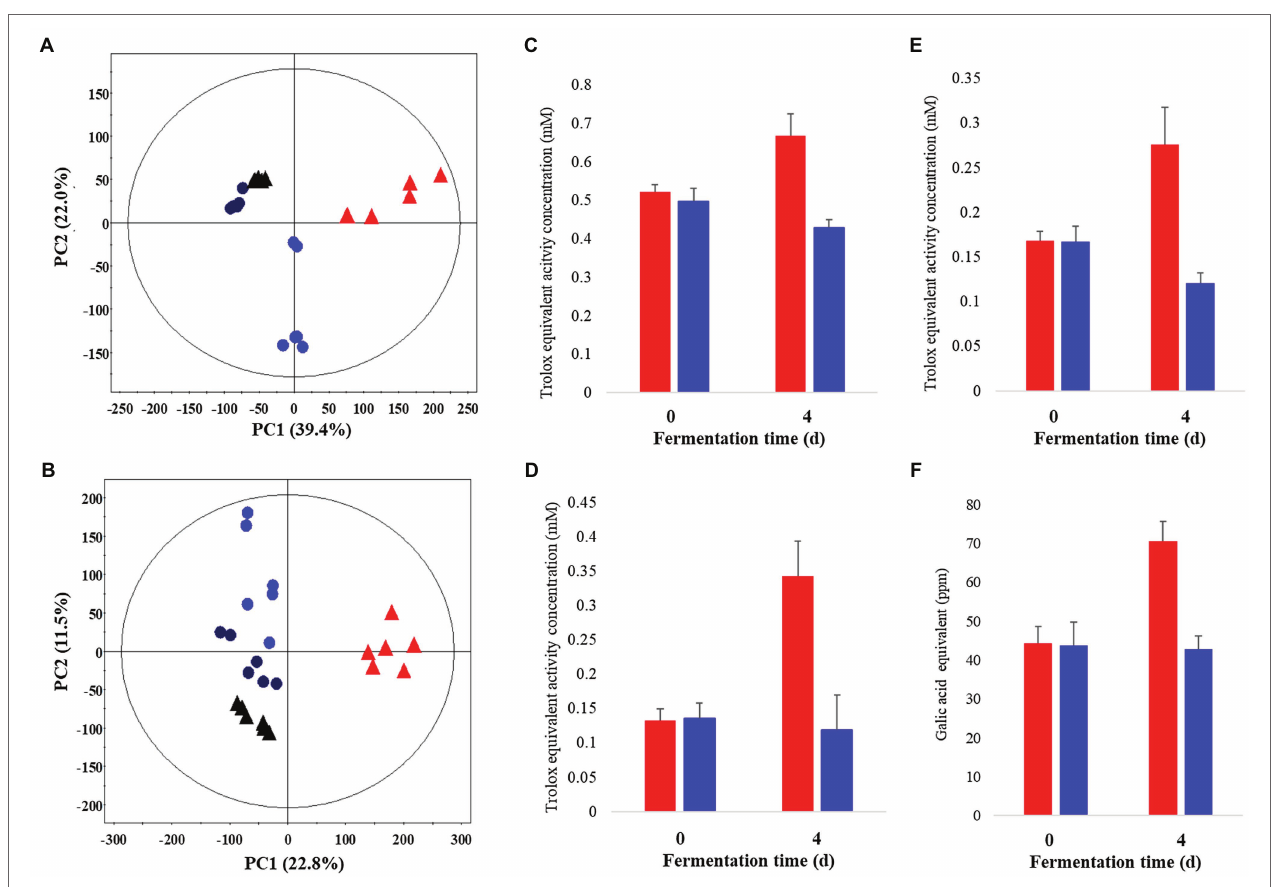
FIGURE 1 | Principal component analysis (PCA) score plot derived from GC-TOF-MS (A) and UHPLC-Q-orbitrap-MS (B) data sets. Comparison of the bioactivities of P. notoginseng during SSF-P and LF-P (C) ABTS, (D) DPPH, (E) FRAP, (F) Total phenol contents. , black: day 0 of solid-state fermentation (SSF-P);